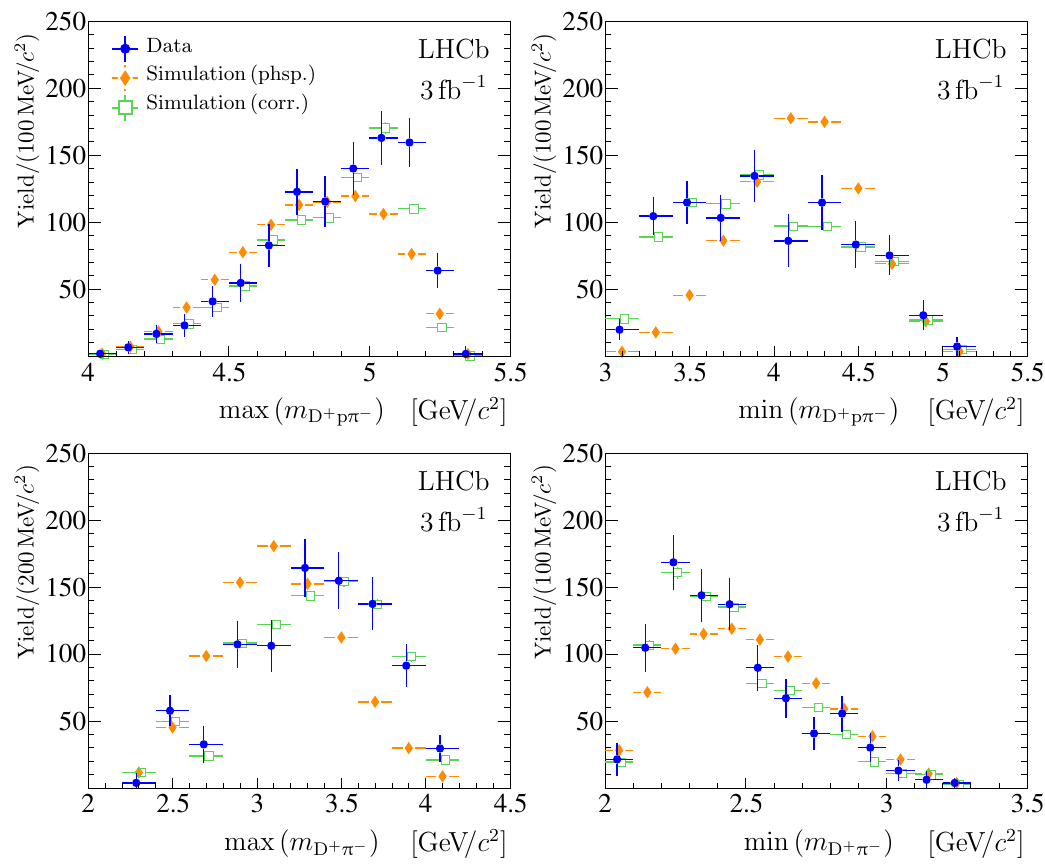
Figure 8 . Background-subtracted maximum and minimum D + pπ − , and maximum and minimum D + π − mass spectra for Λ 0 → D ∗ + pπ − π − decays. Expectations from phase-space (phsp.) and b corrected (corr.) simulation are